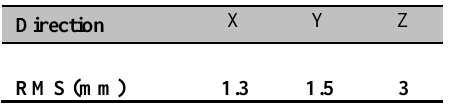
Table 1. Accuracy assessment between our technique and Autralis (Z axis is in direction of first camera’s focal length) When experimental result examined,